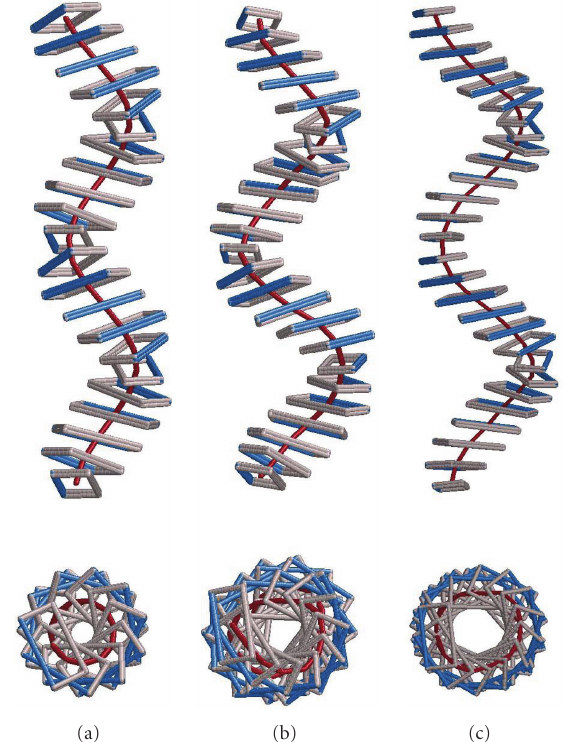
Figure 4: Structure of an idealized RNA helix (a) compared to the RNA/LNA hybrid helix derived from the structure with PDB code 1H0Q (b) and compared to an “all LNA” helix derived from the structure with PDB code: 2X2Q (c) as Calladine-Drew plot. To visualize the overall geometry, the helices were extended to 22 base pairs for RNA, to 25 base pairs for the RNA/LNA, and to 28 base pairs for LNA, respectively